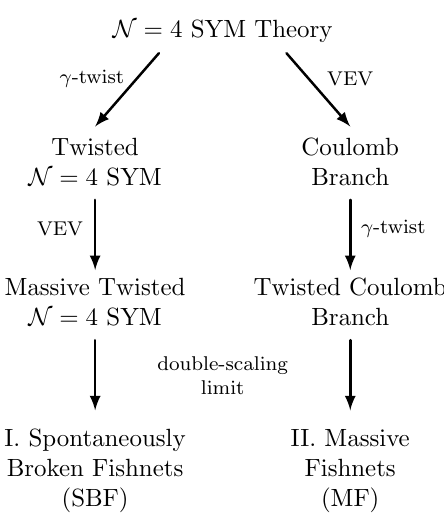
Figure 1 . Routes to massive